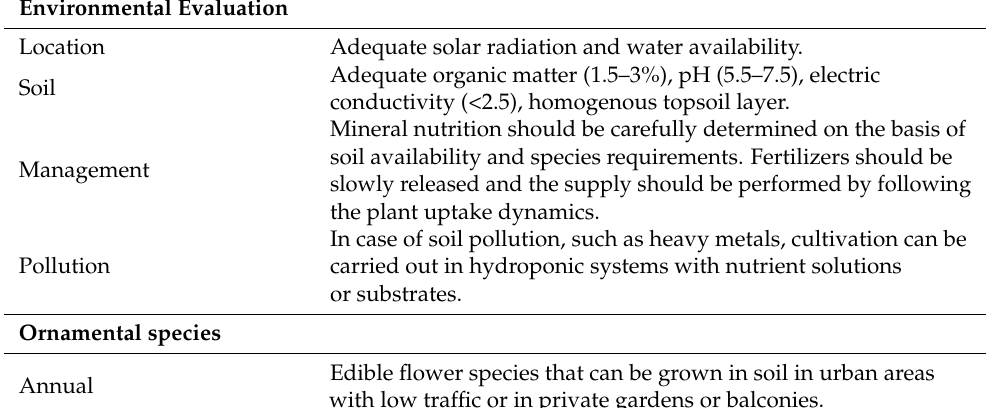
Table 2. The main parameters and strategies that should be taken into consideration. Environmental